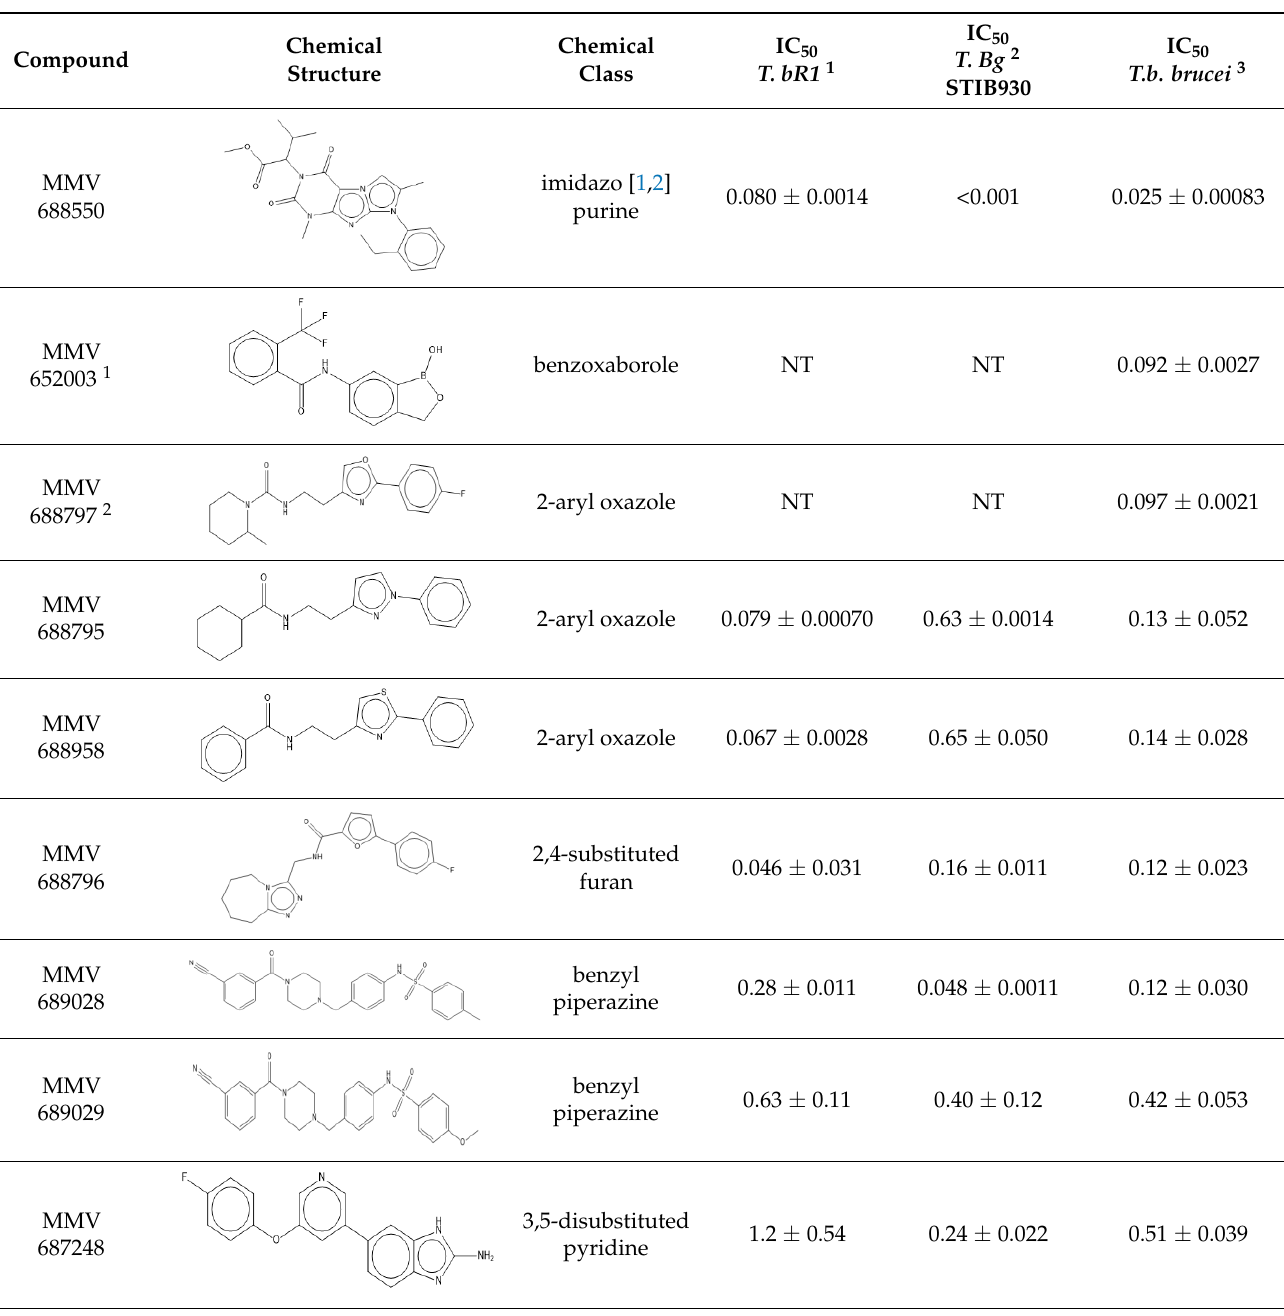
Table 3. Activity against the human infective forms of HAT, T.b. gambiense and T.b. rhodesiense of fast-acting MMV Pathogen Box compounds active against T.b. brucei and T. cruzi .